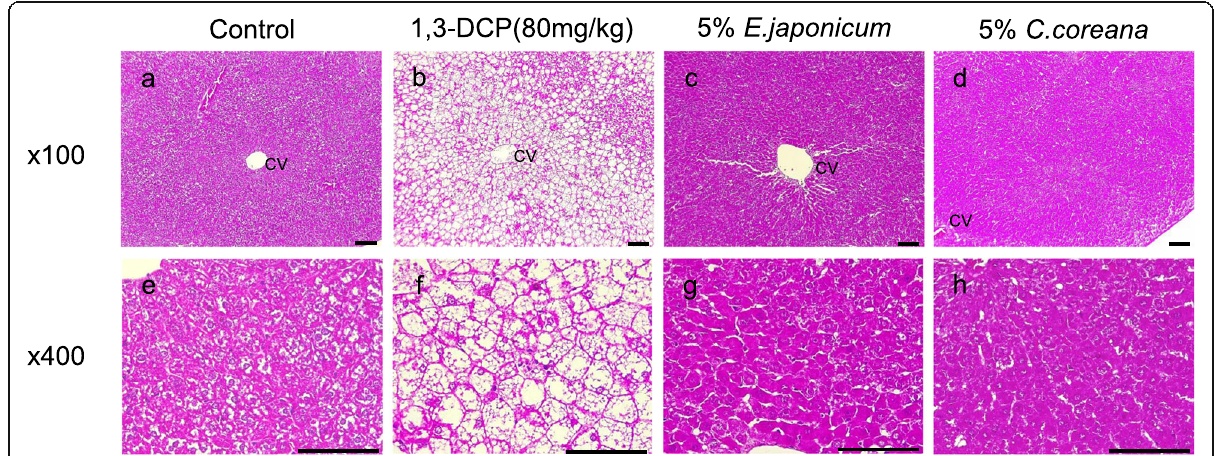
Fig. 1 Histopathological features on the protective effects of Erythronium japonicum and Corylopsis coreana Uyeki against a model of 1,3-dichloro- 2-propanol (1,3-DCP)-induced hepatotoxicity. Representative photographs of liver sections of a , e control showing glycogen vacuolation and b , f 1,3-DCP (80 mg/kg) showing various histopathological alterations characterized by degeneration/necrosis of hepatocytes around the central vein region, vacuolation, inflammatory cell infiltration, hemorrhage. Rats treated with 1,3-DCP at does of c , g 5% E.japonicum, d , h 5% C.coreana. Hematoxylin and eosin stain; Central vein; scale bar = 50 μ m (× 100, × 400); 1,3-DCP: